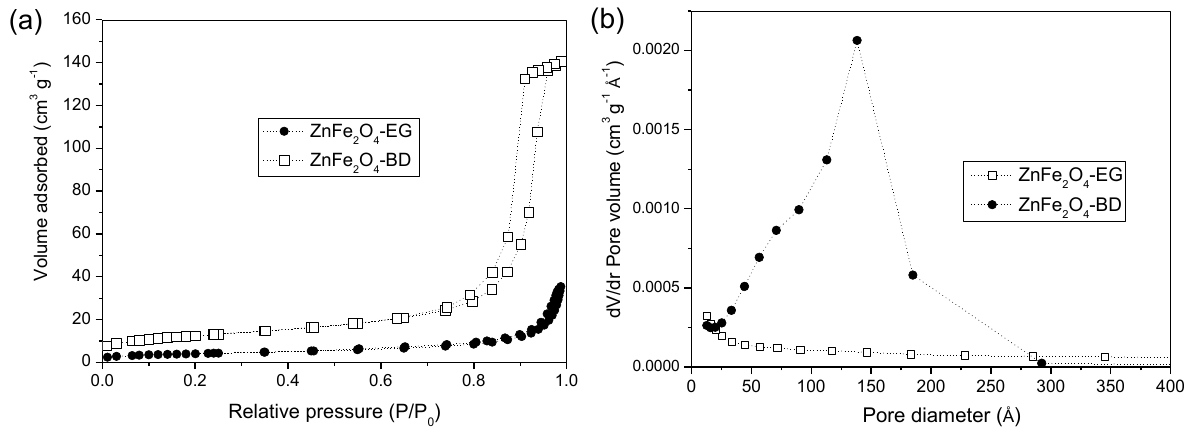
Figure 3. ( a ) N adsorption-desorption isotherms measured at 77 K; and ( b ) pore size 2 distribution curves from the adsorption branches using the BJH